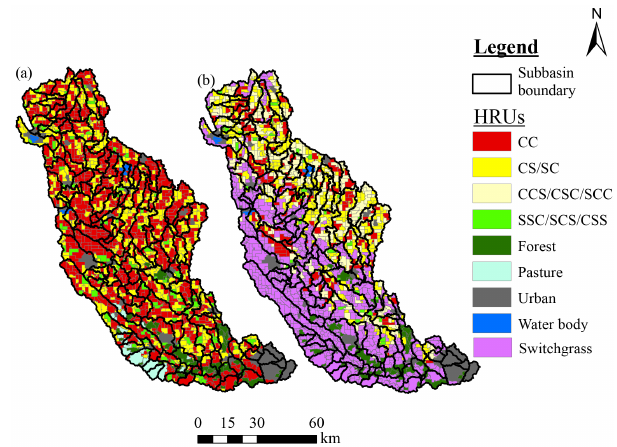
Figure 2. (a) Partial corn and (b) partial switchgrass agricultural scenarios (CC is continuous corn rotation, CS/SC is corn-soybeans rotation, CCS/CSC/SCC is 2 years of corn and 1 year of soybeans in 3-year rotation, SSC/SCS/CSS is 2 years of soybeans and 1 year of corn in 30-year